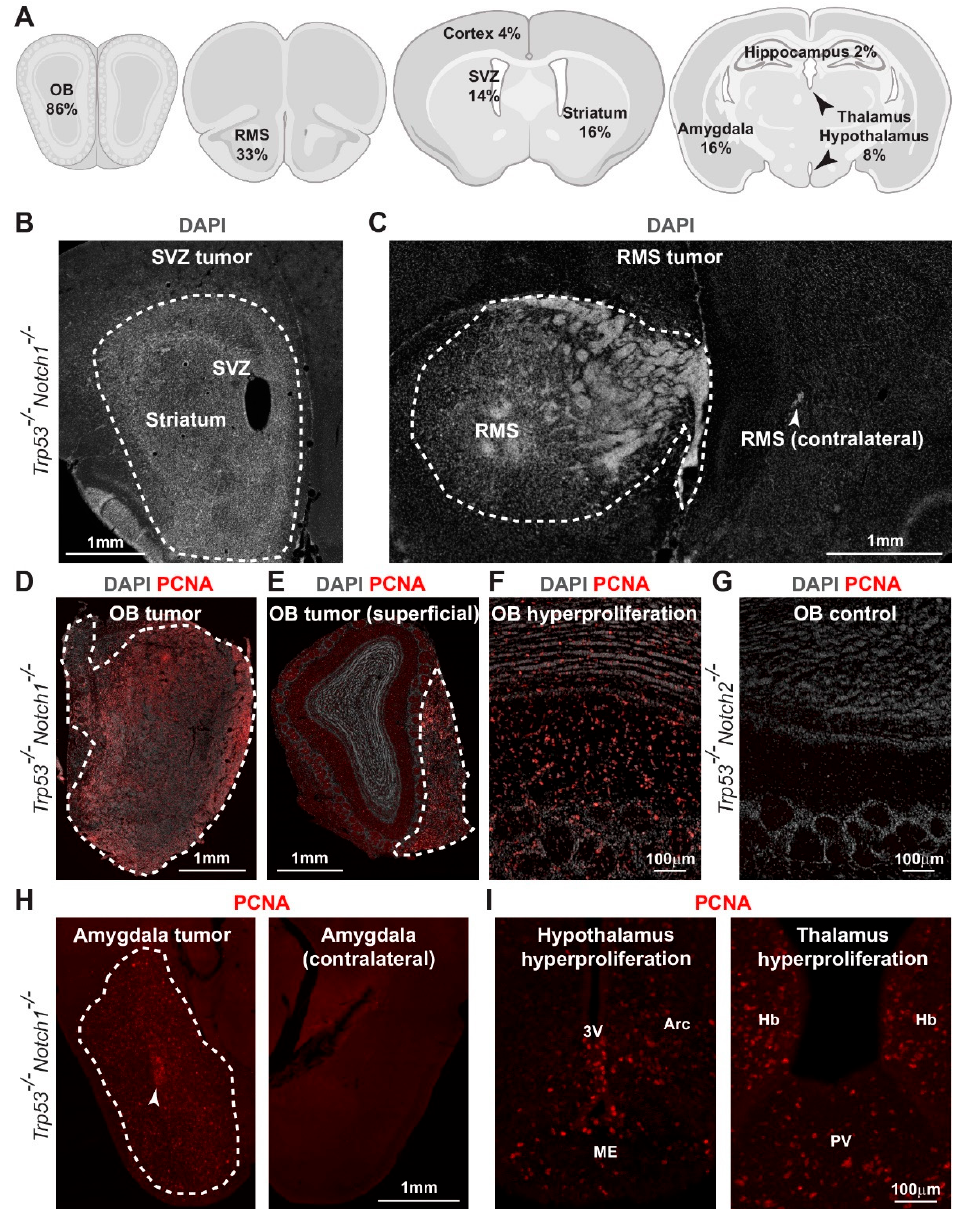
Figure 5. Hyperplasia and tumors are preferentially located in ventral forebrain regions and olfactory bulbs. ( A ) Representative schemes of sections of the mouse brain at different anteroposterior levels summarizing the distribution of hyperplasia and tumors. Percentages of mice with hyperplasia or tumors in a given location is indicated (see also Supplementary Table S1). ( B ) A Trp53 -/- Notch1 -/- tumor (dashed line) in the SVZ and adjacent striatum. ( C ) A Trp53 -/- Notch1 -/- tumor (dashed line) in the RMS and adjacent brain parenchyma. The contralateral RMS is indicated by the arrowhead. ( D ) A Trp53 -/- Notch1 -/- tumor (dashed line) that entirely occupies the OB. ( E ) A Trp53 -/- Notch1 -/- tumor (dashed line) located on the surface of the OB. ( F ) A diffuse, proliferating (PCNA) Trp53 -/- Notch1 -/- hyperplasia that invades all OB layers. ( G ) No signs of hyperplasia in the OB of a Trp53 -/- Notch2 -/- mouse. ( H ) A Trp53 -/- Notch1 -/- tumor (dashed line) in the amygdala region. Note the denser core of the tumor located in the lateral nucleus of the amygdala (arrowhead). The contralateral, tumor- free amygdala is also shown. ( I ) PCNA + hyperplasia in the hypothalamus and thalamus of a Trp53 -/- Notch1 -/- mouse. 3V, 3rd ventricle; Arc, arcuate nucleus; ME, median eminence; Hb, habenular nucleus; PV, periventricular thalamic